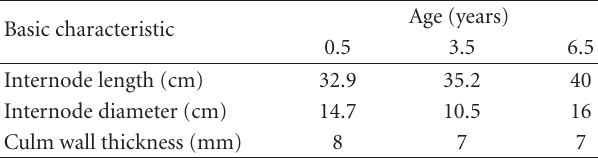
Table 1: Basic characteristics of the sixth internode bamboo culm. Table 2: Standard used for chemical analysis.